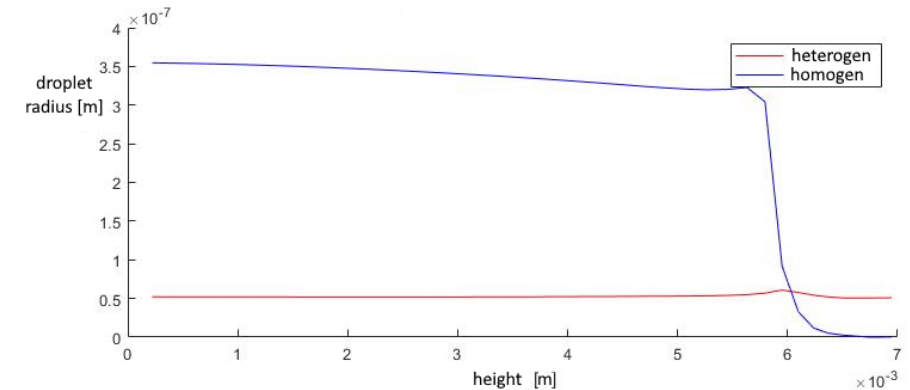
Figure 17. The average droplet size in the outlet section of the diffuser.